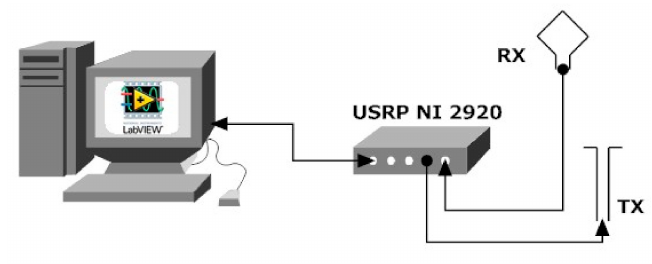
Figure 4. Software-defined radar (SDRadar) schematic